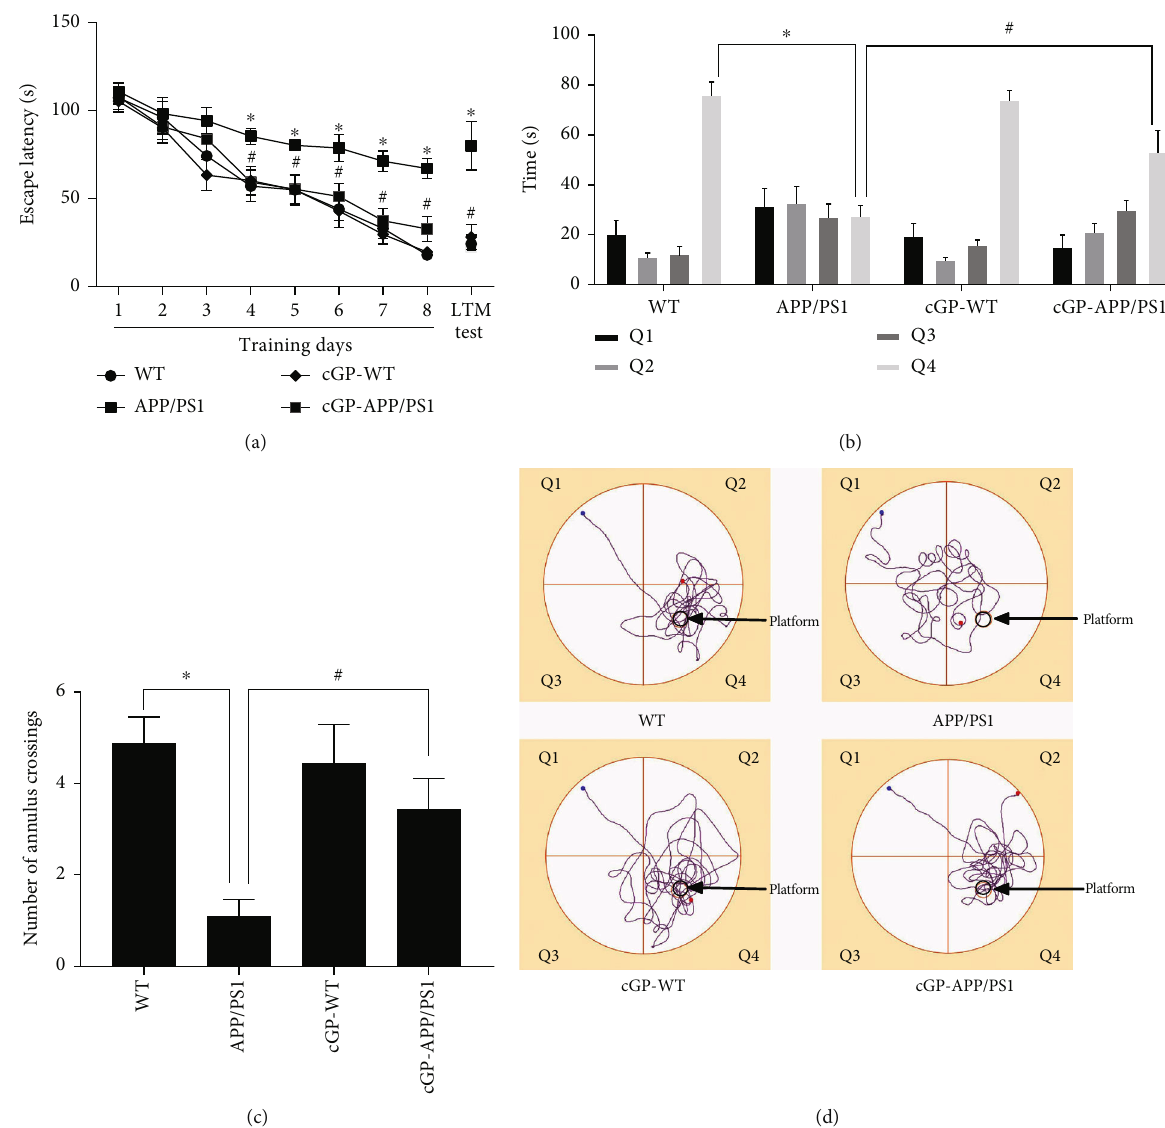
Figure 1: cGP improves memory in APP/PS1 mice. cGP treatment was given to wild-type (WT) and APP/PS1 mice. (a) Escape latency during the 8 days of training and during the long-term memory (LTM) test ( n = 9 in all groups). There were signi fi cant di ff erences in escape latency between APP/PS1 mice and WT mice day 4 onwards during the course of training and also during the LTM test. cGP- treated APP/PS1 (cGP-APP/PS1) mice showed signi fi cantly reduced escape latency compared to APP/PS1 mice day 4 onwards during the training and during the LTM test. Escape latencies of WT mice and cGP-treated wild-type (cGP-WT) mice were similar throughout the training and during the LTM test. (b) Time spent in di ff erent quadrants during the probe trial (LTM test in (a)). APP/PS1 mice spent signi fi cantly less amount of time in platform quadrant (Q4) than the WT mice. cGP-APP/PS1 mice spent signi fi cantly more time in the platform quadrant compared to untreated APP/PS1 mice. cGP-WT mice and WT mice spent similar amount of time in the platform quadrant. (c) Number of annulus crossings during the probe trial (LTM test in (a)). APP/PS1 mice displayed signi fi cantly reduced number of annulus crossings compared to WT mice. cGP-APP/PS1 mice showed signi fi cantly increased number of annulus crossings compared to untreated APP/PS1 mice. WT mice and cGP-WT mice showed similar number of annulus crossings. (d) The representative track plots during the probe trial (LTM test in (a)). Asterisks denote signi fi cant di ff erence ( p < 0 : 05 ) between the WT and APP/PS1 groups, and # denotes signi fi cant di ff erence between the APP/PS1 and cGP-APP/PS1